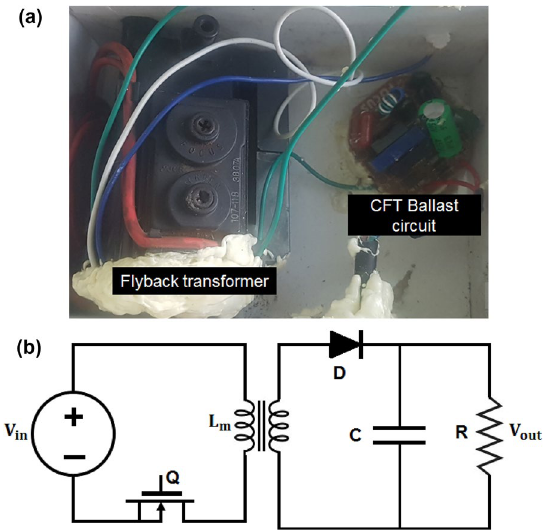
Figure 2. ( a ) Strong ionization voltage supply shoeing flyback transformer and CFT ballast circuit and ( b ) equivalent circuit of FBT adapted from Salem 23